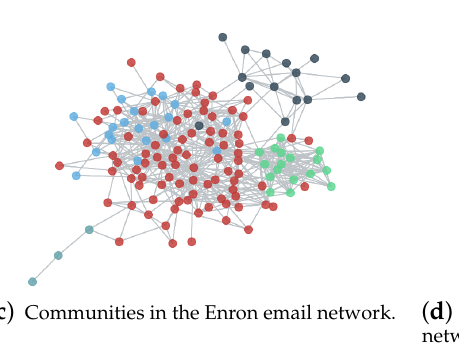
( a ) Two communities in Karate club network. ( b ) Top-two influencers in the folded Karate club network.